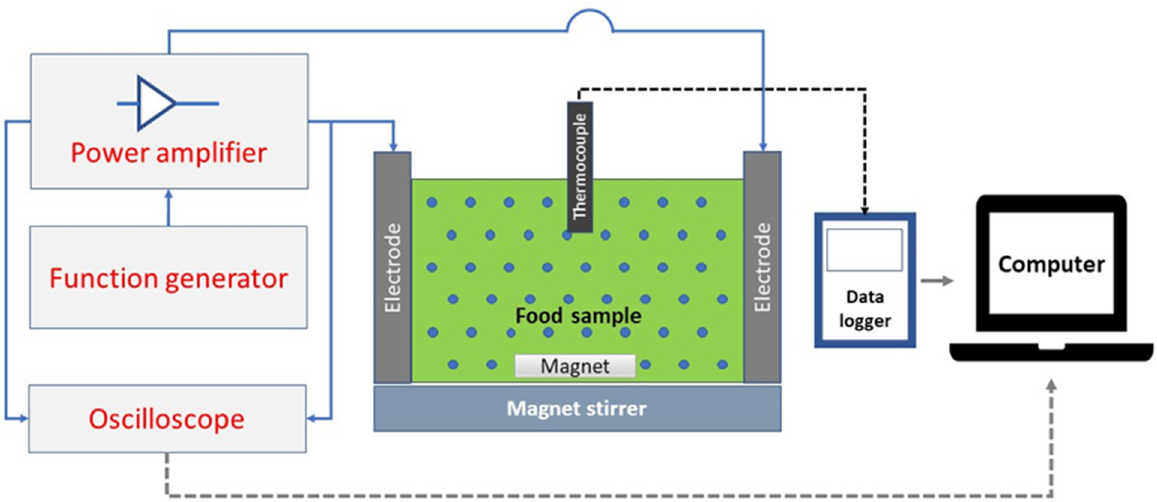
Figure 2. Layout of ohmic heating system used for olive leaf extraction.